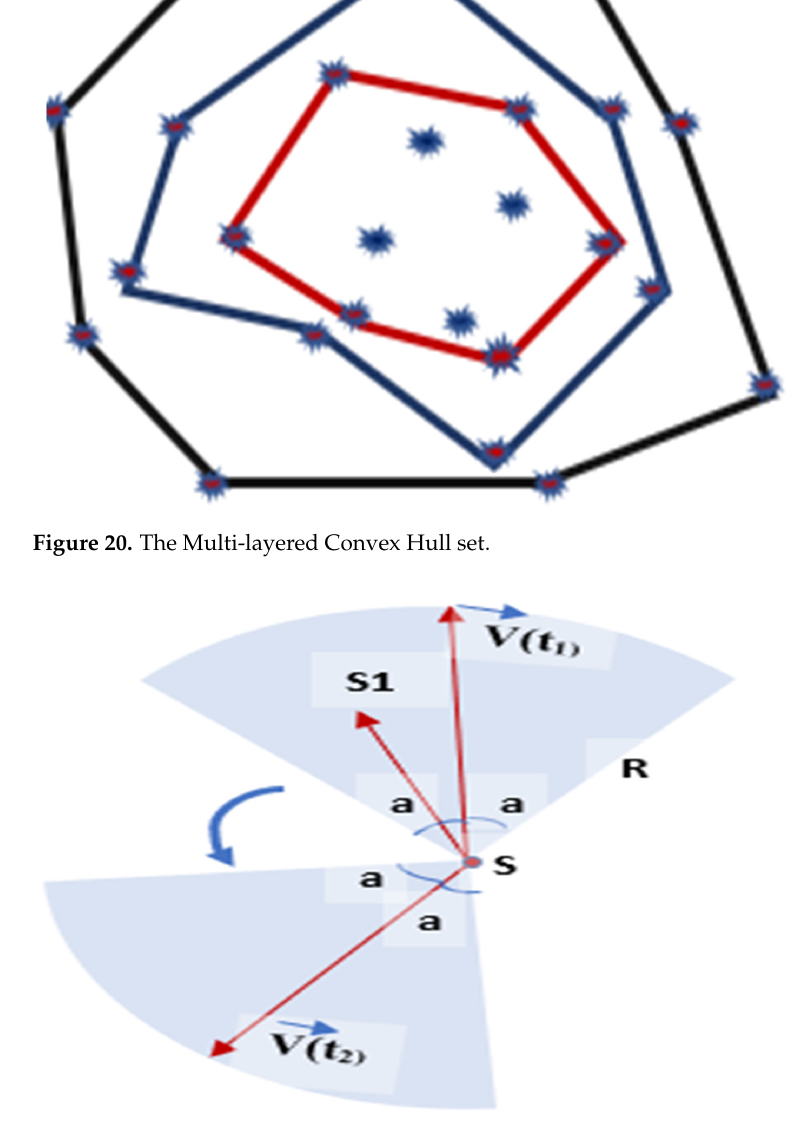
Figure 21. Sensing directions of directional nodes.